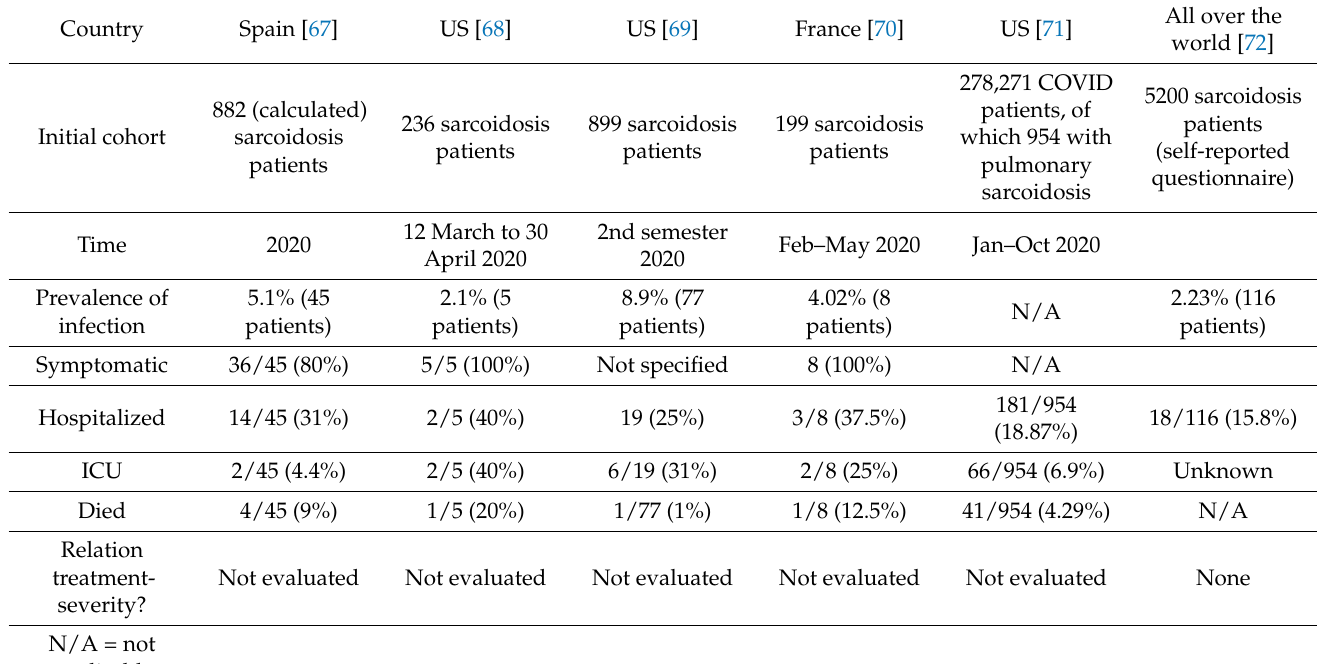
Table 1. Studies reporting the impact of SARS-CoV-2 infection in sarcoidosis